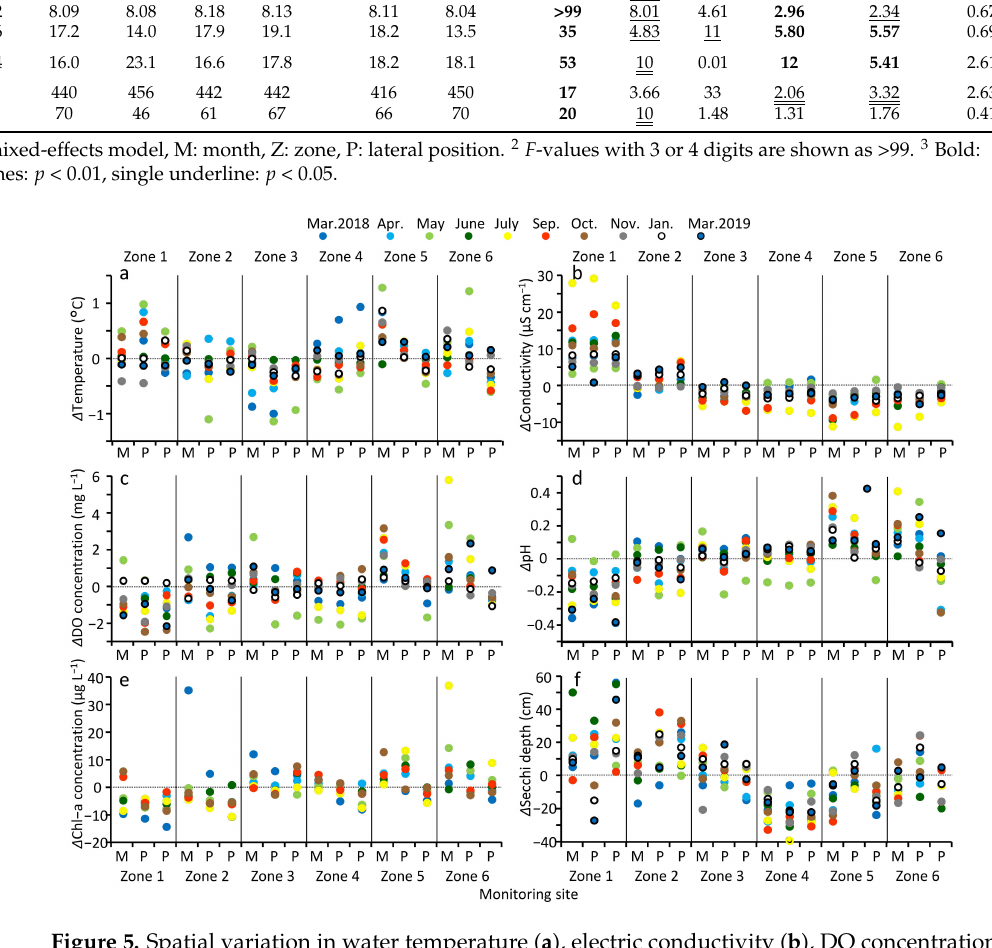
Figure 5. Spatial variation in water temperature ( a ), electric conductivity ( b ), DO concentration ( c ), pH ( d ), Chl-a concentration ( e ), and transparency ( f ) among survey sites in MA shown by difference from the mean of each month ( ∆ ). M: middle, P: